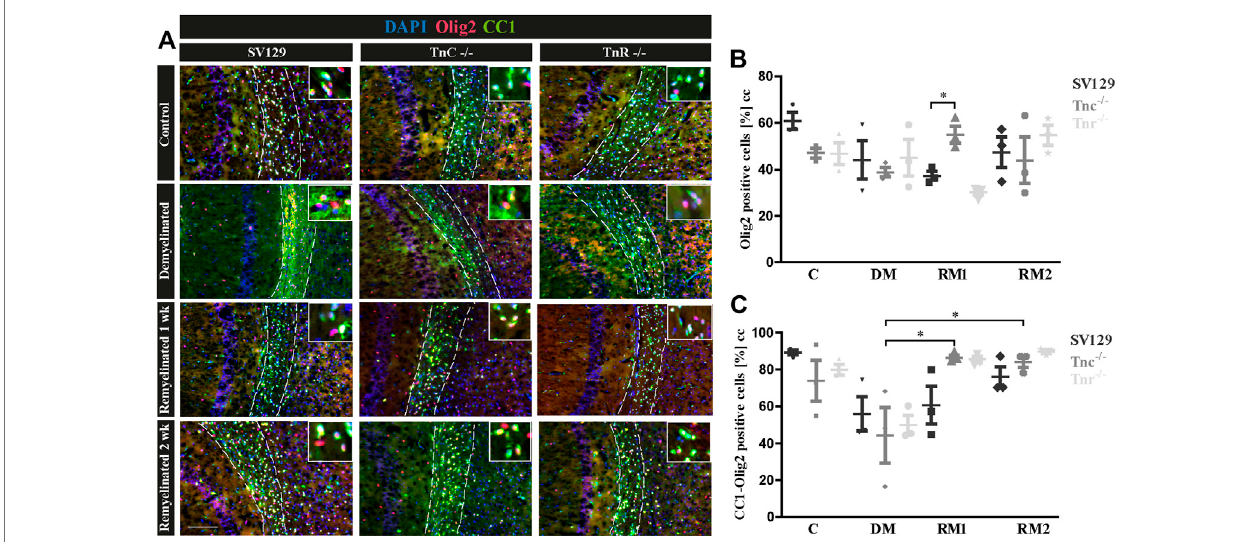
FIGURE 7 | (A – C) Comparison of Olig2/CC1-double immunolabeling in the corpus callosum of SV129, Tnc − / − , and Tnr − / − mice under control, demyelinated, and remyelinatedconditions. (A) UsingimmunohistochemicallabelingwithantibodiesagainstOlig2(detectsalloligodendroglia)andCC1(detects matureoligodendrocytes), the percentage of mature oligodendrocytes in the corpus callosum of SV129 , Tnc − / − , and Tnr − / − mice was compared. The four conditions “ control, ” “ demyelinated, ” “ one-weekremyelinated, ” and “ two-weeksremyelinated ” wereexamined.DAPI-stainingmarkscellnucleiinbluecolor.Olig2isnucleus-basedstaining,andCC1is located in the cytosol. In the absence of treatment, a strong labeling of CC1-positive cells (green) was detectable in the corpus callosum (CC) of all genotypes. Mature CC1/Olig2-positive cells were reduced in the demyelinated condition. (B) Quanti fi cation of Olig2-positive cells in the particular conditions (C: control, DM: demyelinated, RM1: one-week remyelinated, RM2: two-weeks remyelinated). (C) Quanti fi cation of CC1/Olig2-double immunopositive cells. The quanti fi cation con fi rms a lower percentage of mature oligodendrocytes in the demyelinated condition compared to the control for all genotypes. All data are provided as mean ± SEM. The statistical signi fi cance was assessed by using the two-way ANOVA (* p ≤ 0.05, ** p ≤ 0.01, *** p ≤ 0.001) and Tukey ’ s multiple-comparisons test. The micrograph of the illustration was captured via Axiophot. Scale bars: illustration: 100 µm detail, pictures: 50 μ m; at least N = 3 animals were used for each group and genotype, and at least n = 500 cells were evaluated for each individual